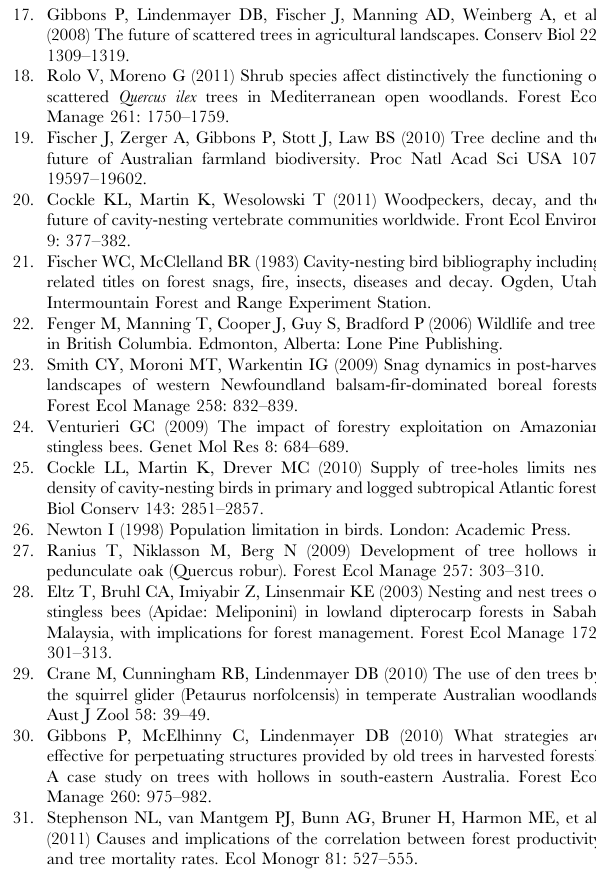
Figure S1 Collapsed tree on an unburned site, and fire- consumed tree on a site burned at moderate severity.